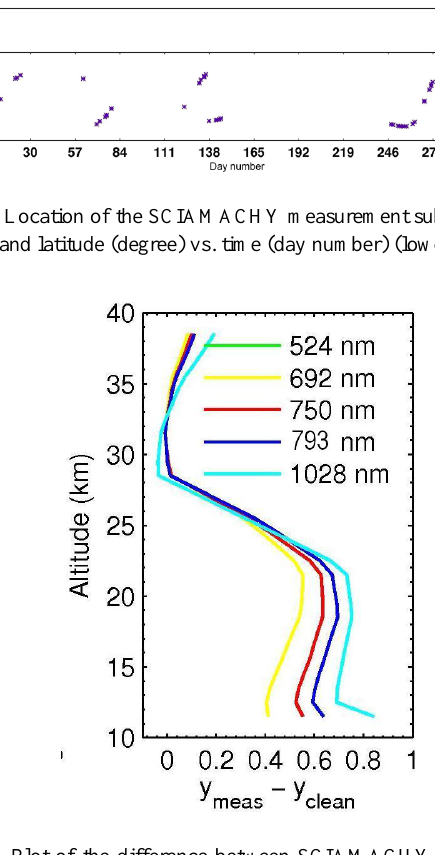
Fig. 8. Plot of the difference between SCIAMACHY normalized measured ( y meas ) and modeled radiance ( y clean ) with no aerosol, at 524, 692, 750, 793, and